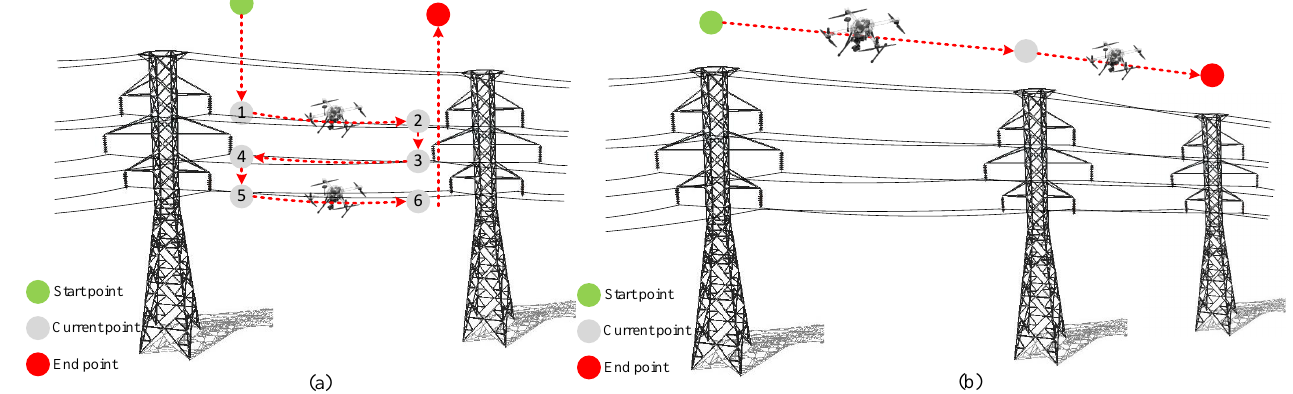
Figure 4. ( a ) The process of arc-chasing inspection; ( b ) The process of channel